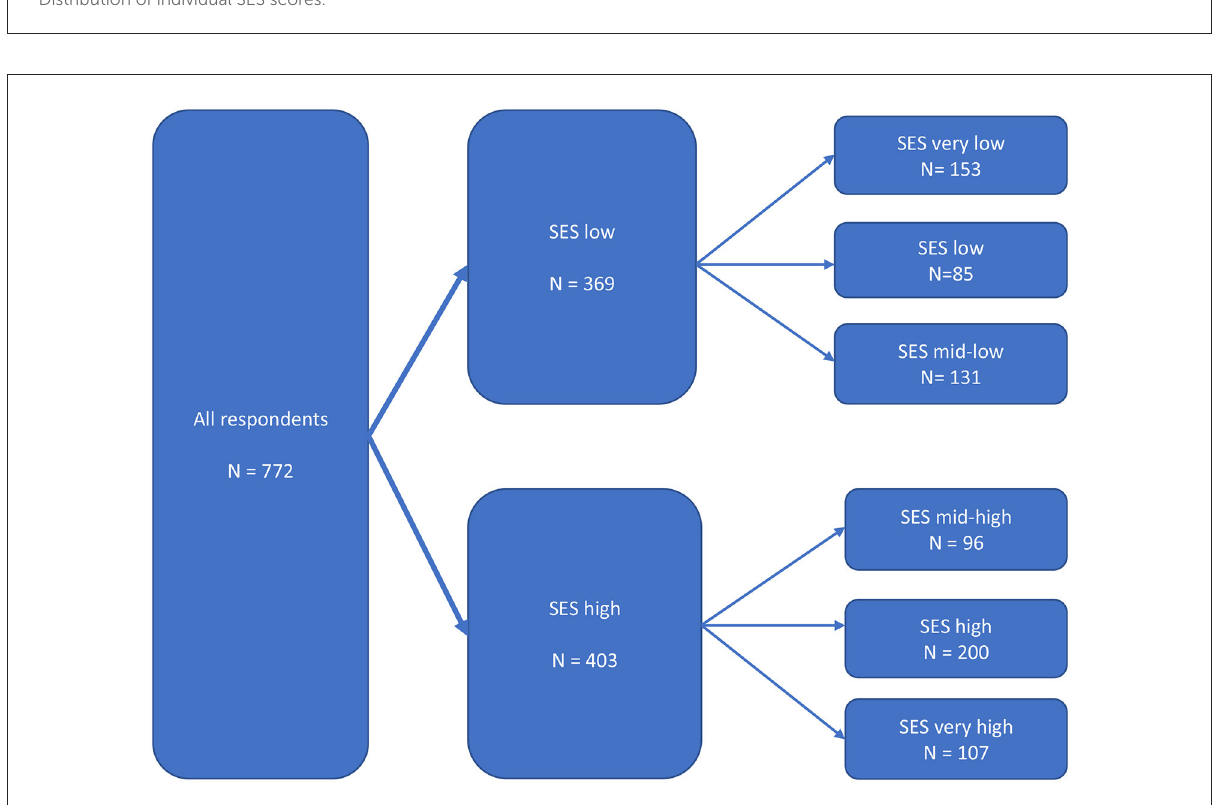
FIGURE3 Structure of the empirical analysis.